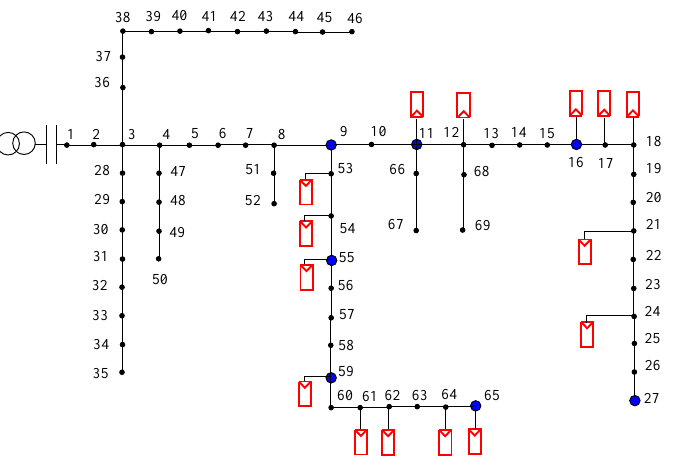
Figure 5. The IEEE 69 bus distribution grid. In red the PV and in Blue the point of observation. The single-phase IEEE 69, bus grid is first extended to a three-phase network by replicating the deterministic single-phase loads (i.e., the nominal active and reactive powers they absorb) at the three phases of each bus. Second, uncertainty is reproduced into the